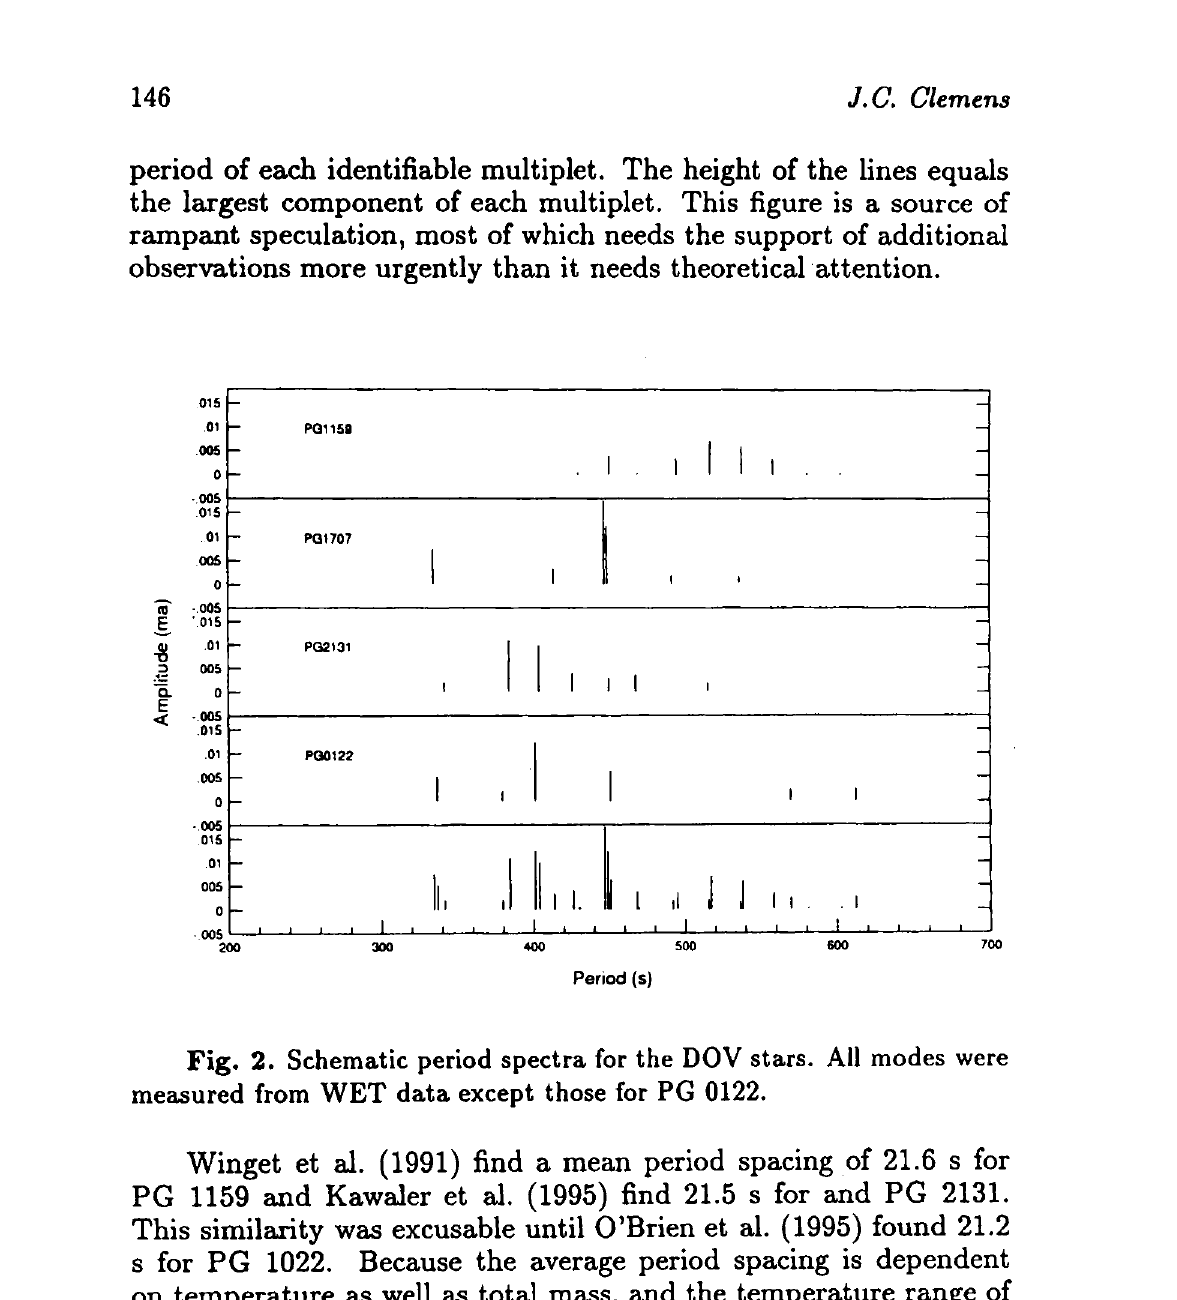
Fig. 2. Schematic period spectra for the DOV stars. All modes were measured from W ET data except those for PG